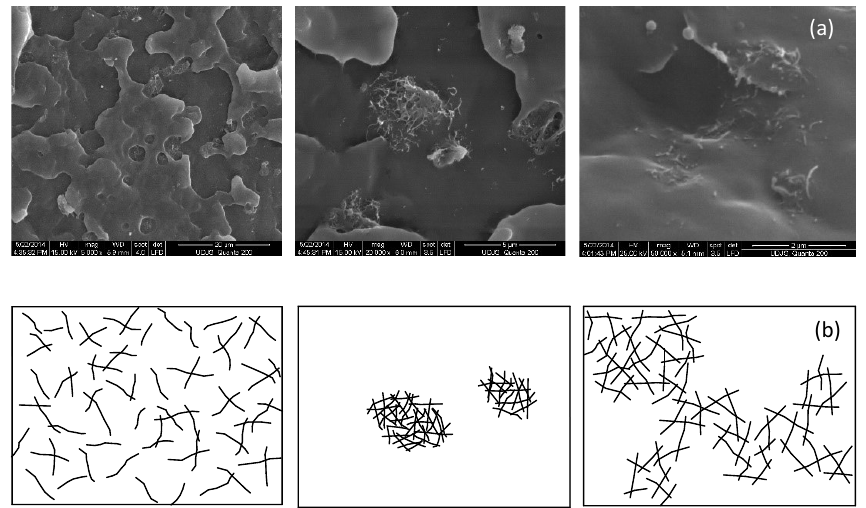
Figure 2. SEM images of the polypropylene (PP) / multi-walled carbon nanotubes (MWCNT) nanocomposite with 5 wt % ( a ) and schematic representation of MWCNTs ( b ).